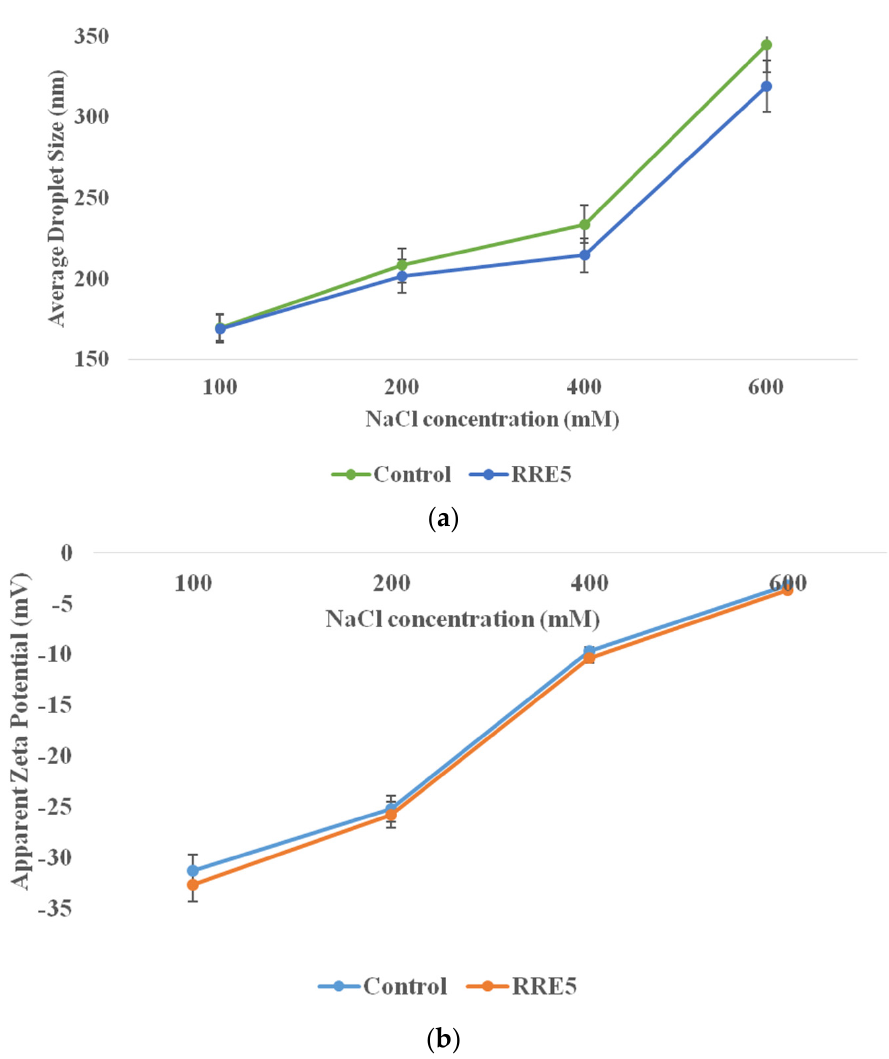
Figure 6. ( a ) Effect of NaCl concentration on average droplet size, and ( b ) effect of NaCl concentration on apparent zeta potential of RRE5 nanoemulsion. Data are presented as means ± SD ( n = 3).